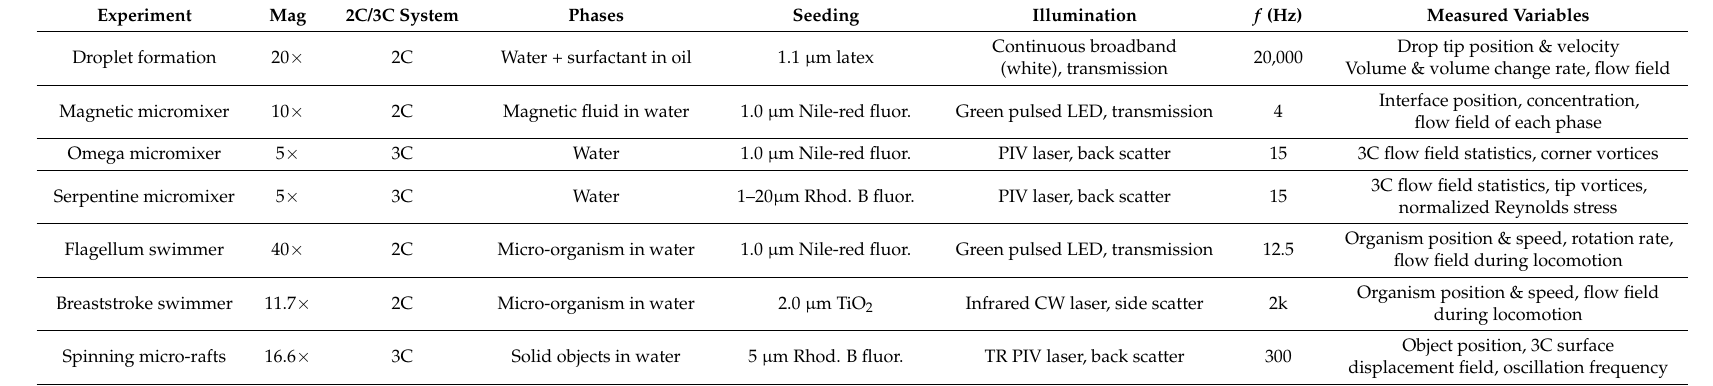
Table 1. Summary of experiment setups and measured variables.